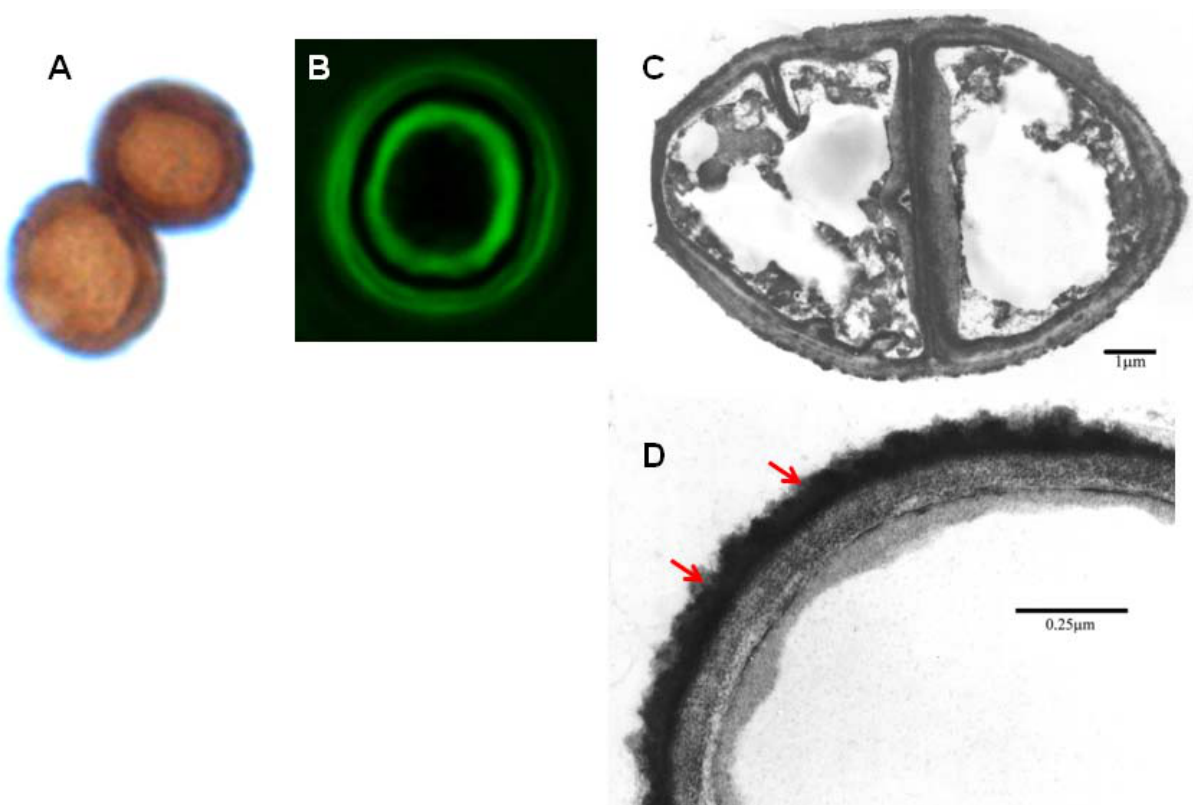
Figure 3. F. pedrosoi chlamydoconidia cells from 6-month cultures. ( A ) Light microscope image (1000x); ( B ) autofluorescent wall layers (1000x); ( C ) TEM of a roundish cell with longitudinal and transverse septa; ( D ) TEM of a wall from terminal chlamydoconidia, showing four layers with an external electrondense